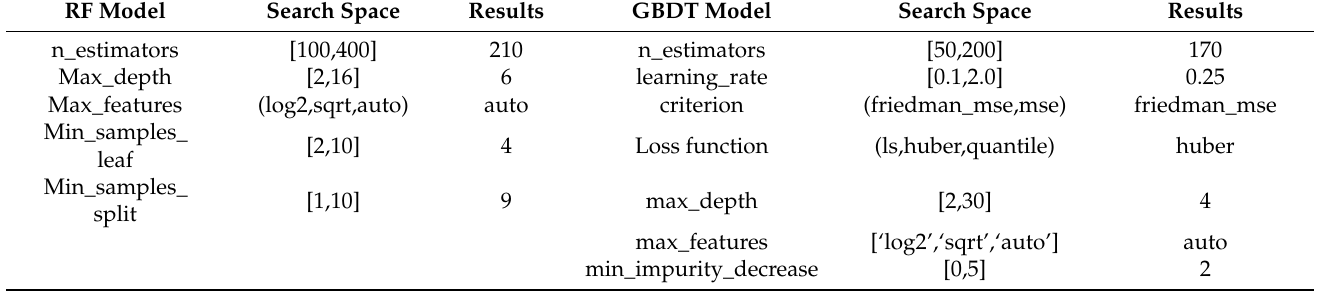
Table 3. Searching space of Bayesian hyper-parameter optimization method.